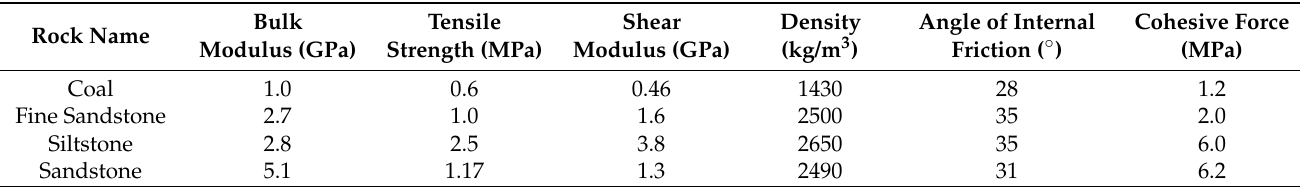
Table 1. Physical and mechanical parameters of rock